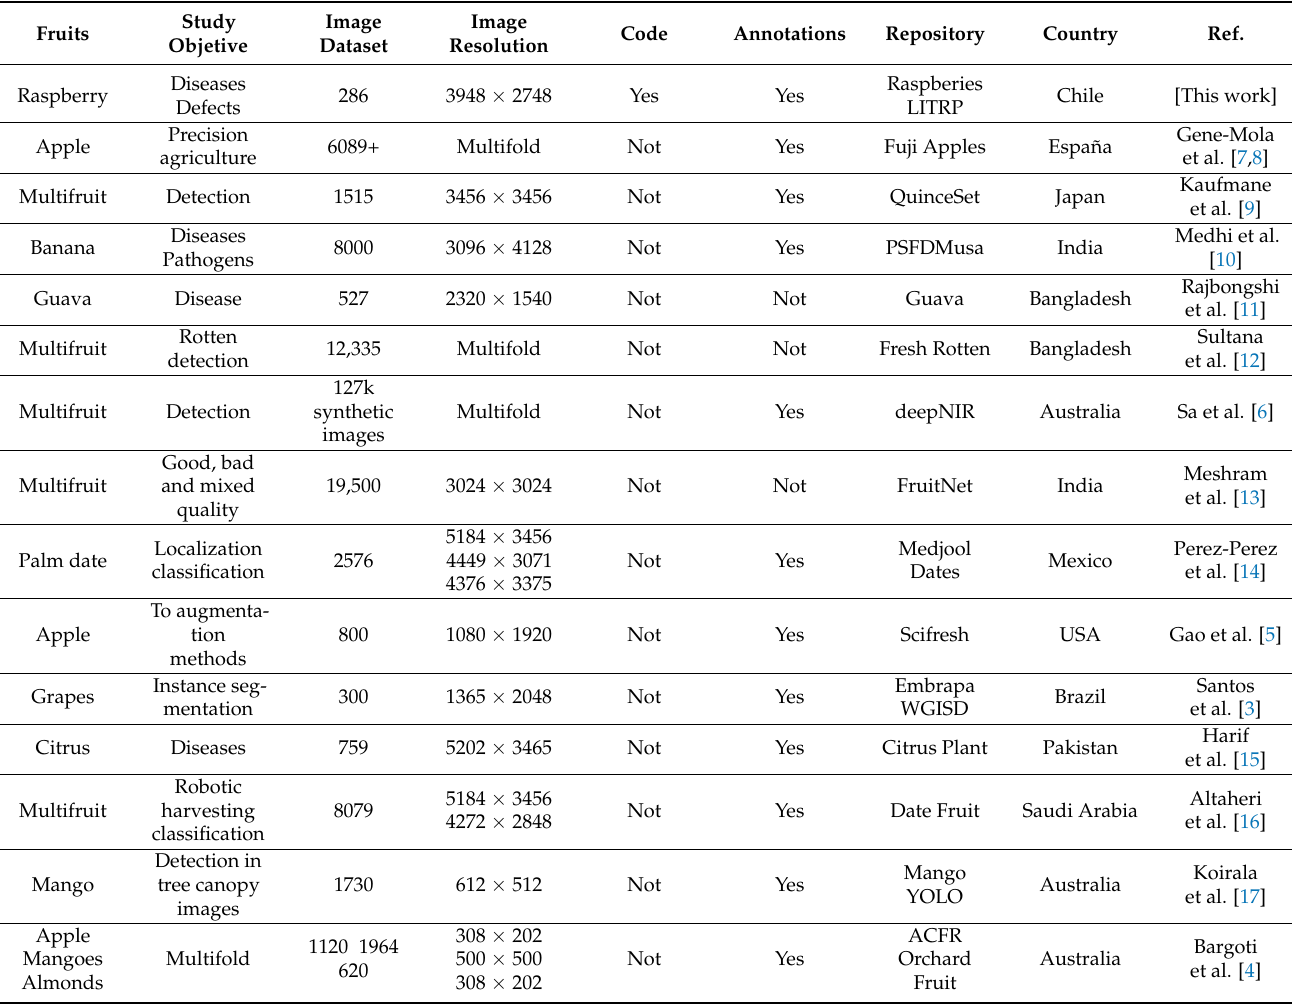
Table 1. Summary of some freely accessible databases related to studies on fruit quality. Data access can be consulted in the